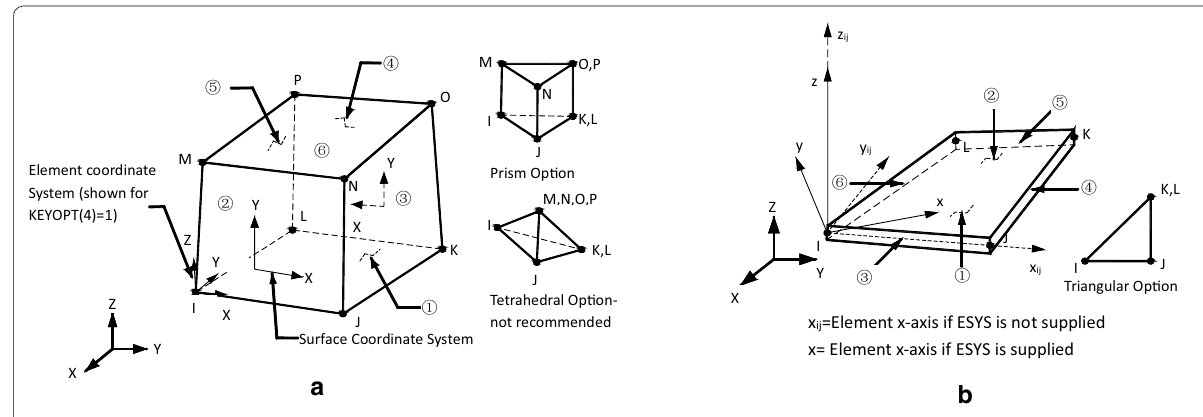
Fig. 10 Details of finite elements: a SOLID45; b SHELL41